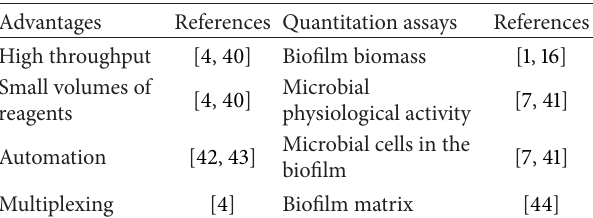
Table 1: Advantages of MTPs as biofilm reactors and standard methods for quantitation of biofilm parameters in